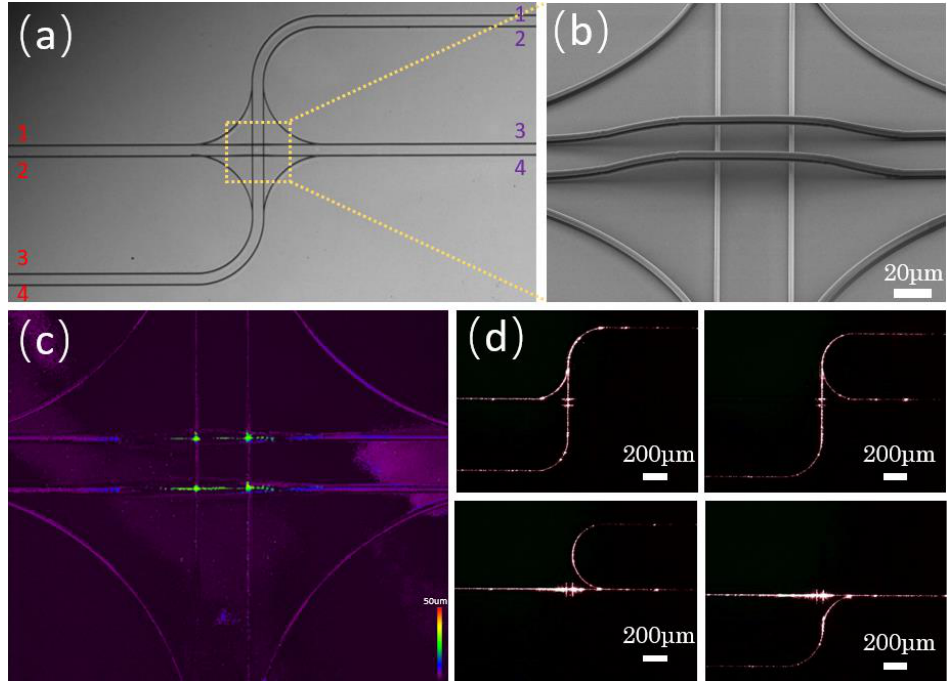
Figure 4. SEM images of ( a ) optical overpass and ( b ) magnified detail. ( c ) Confocal image of the optical overpass. ( d ) Top view of dark field light test of the optical